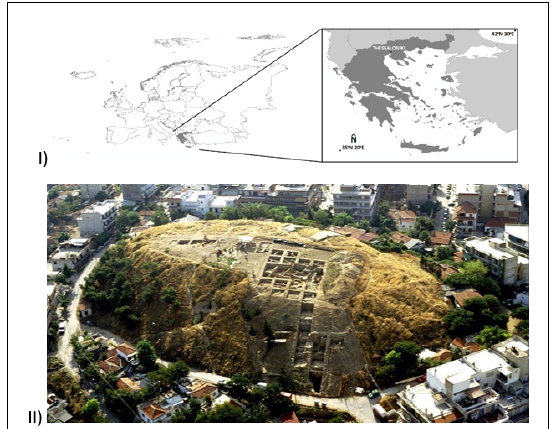
Figure 1 . (I) Thessaloniki, located in Northern Greece, central Macedonia (Source: Google Earth) and (II) Thessaloniki Toumba Excavation as seen from above